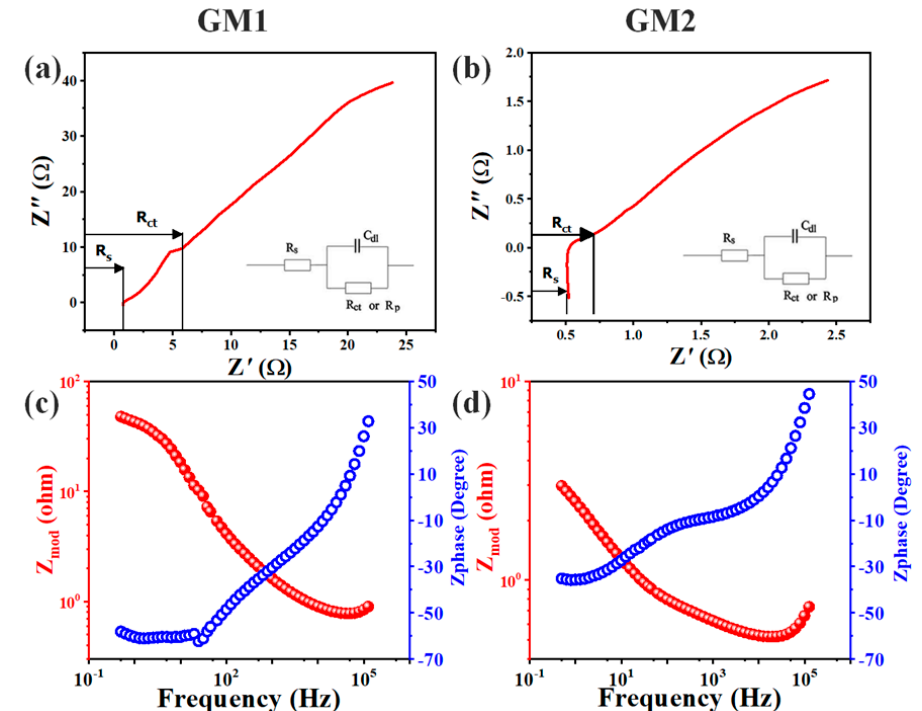
Figure 7. Electrochemical-impedance-spectroscopy (EIS) curves in 6 M KOH solution: ( a ) Nyquist curve of GM1, and inset shows its equivalent circuit; ( b ) Nyquist curve of GM2, and inset shows its equivalent circuit; Bode plots of ( c ) GM1 and ( d ) GM2.